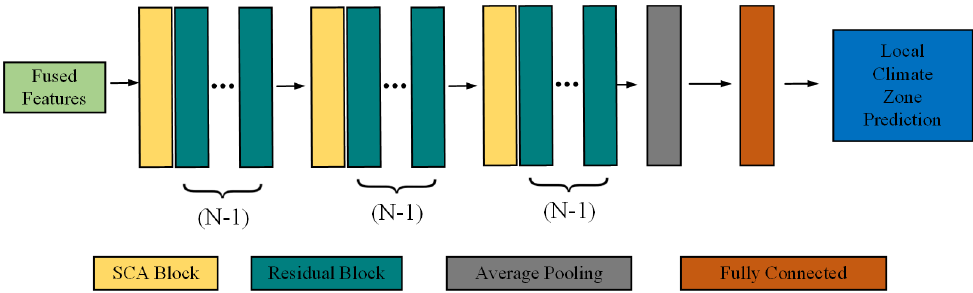
Figure 5. Structure of the classifier for LCZ classification, where N is the depth of each residual